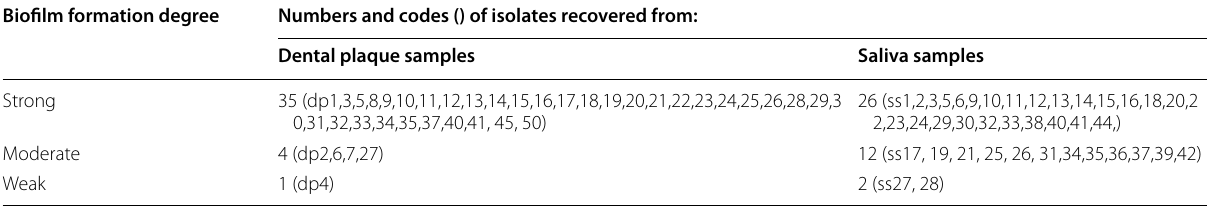
Table 3 Numbers and codes of S. mutans isolates recovered from dental plaque and saliva samples showing strong, moderate and weak biofilm production as determined by microtiter plate Biofilm formation